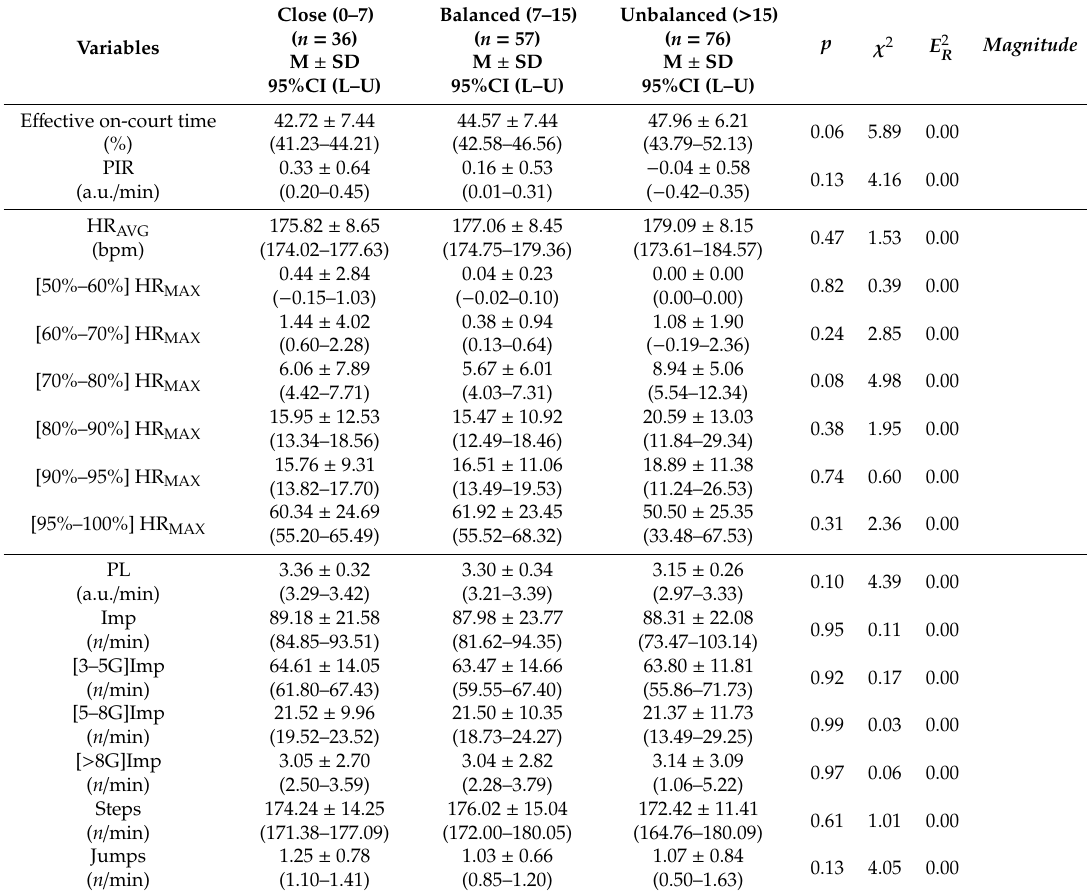
Table 3. Descriptive and inferential analysis of the analyzed variables as a function of the point di ff erence at the end of the